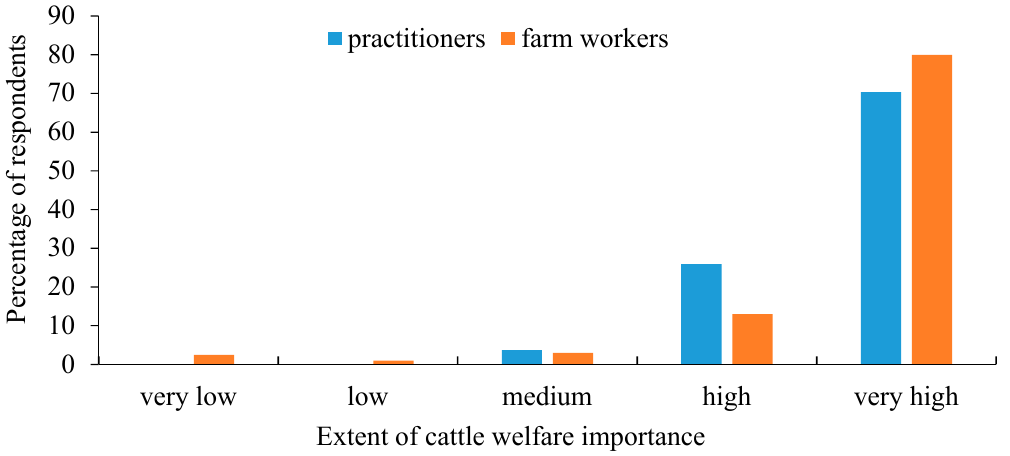
Figure 1. Extent of the veterinary practitioners’ ( n = 27) and farm workers’ ( n = 429) enjoyment from their work on the farm. There were statistical differences between groups.